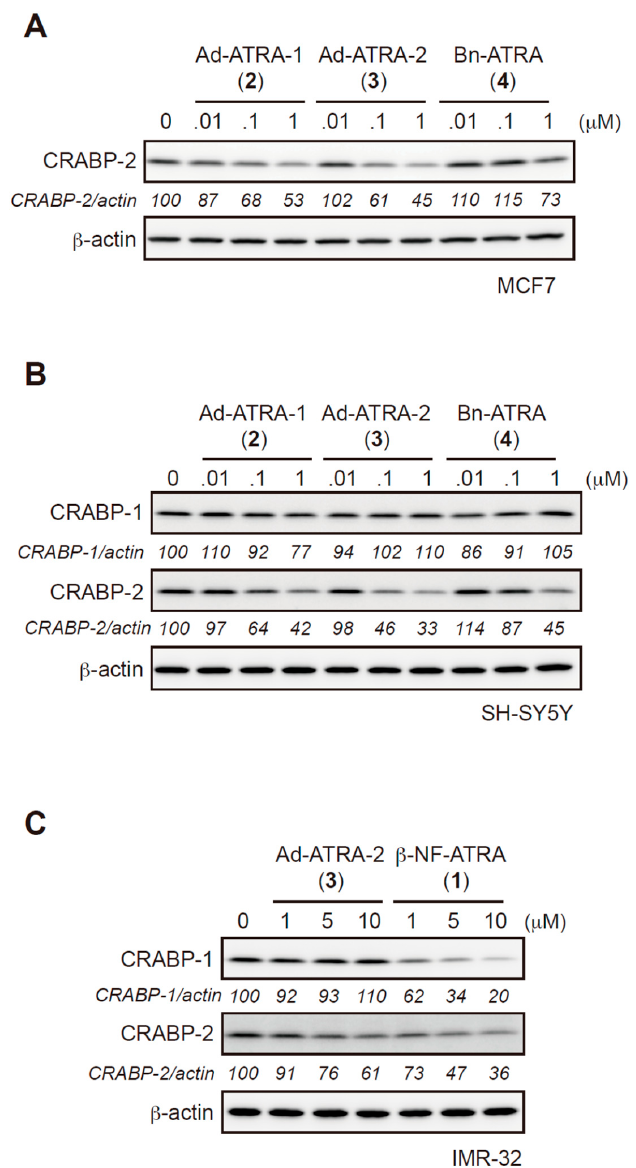
Figure 3. HyT compounds induce the degradation of CRABP-2 but not of CRABP-1. (A–C) Protein knockdown activities of HyT 2 , 3 , and 4 or β -NF-ATRA 1 in MCF-7 (A), SH-SY5Y (B), or IMR-32 cells (C). Cells were treated with the indicated compounds for 24 h. Whole-cell lysates were analyzed by western blotting. The numbers below the CRABP-1 and CRABP-2 panels represent CRABP-1/actin and CRABP-2/actin ratios, respectively, normalized by designating the expression from the vehicle control condition as 100%.